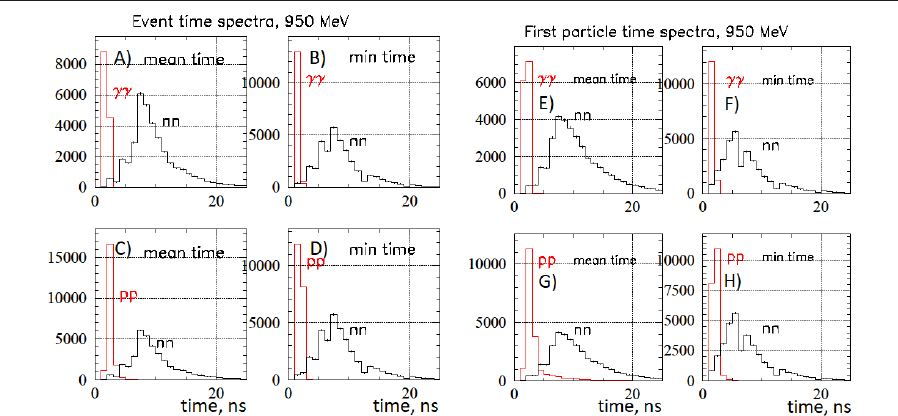
Figure 6. EMC time spectra for e + e − → n ¯ n , e + e − → p ¯ p and e + e − → γγ MC events with EMC signal shape simulation and fitting. The event time is a mean (A, C) or minimum (B, D) time of all successfully fitted EMC signals in the event. The first particle time is a mean (E, G) or minimum (F, H) time of all successfully fitted EMC signals that correspond to a particle with the highest energy deposition in the